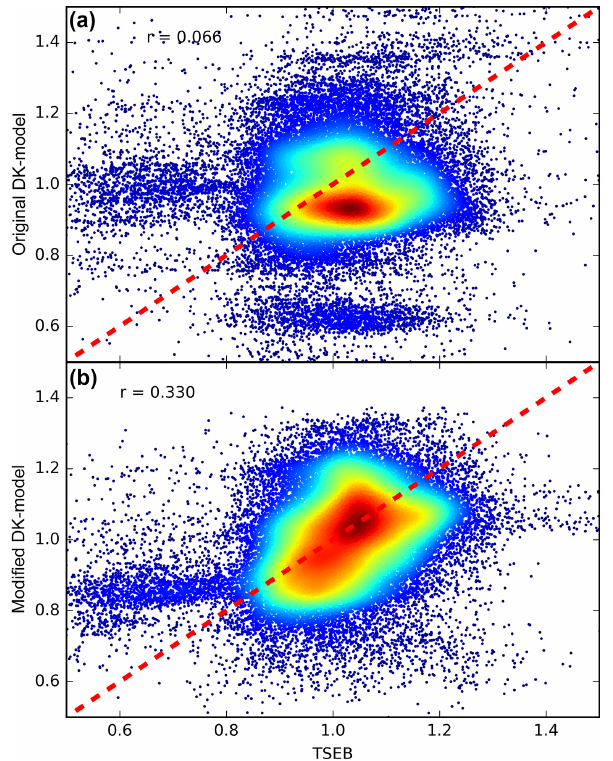
Figure 9. Scatter plots of normalized ET showing the comparison of the TSEB against the two DK-model configurations. The upper scatter plot compares the TSEB against the original DK-model, and the lower compares it against the modified DK-model